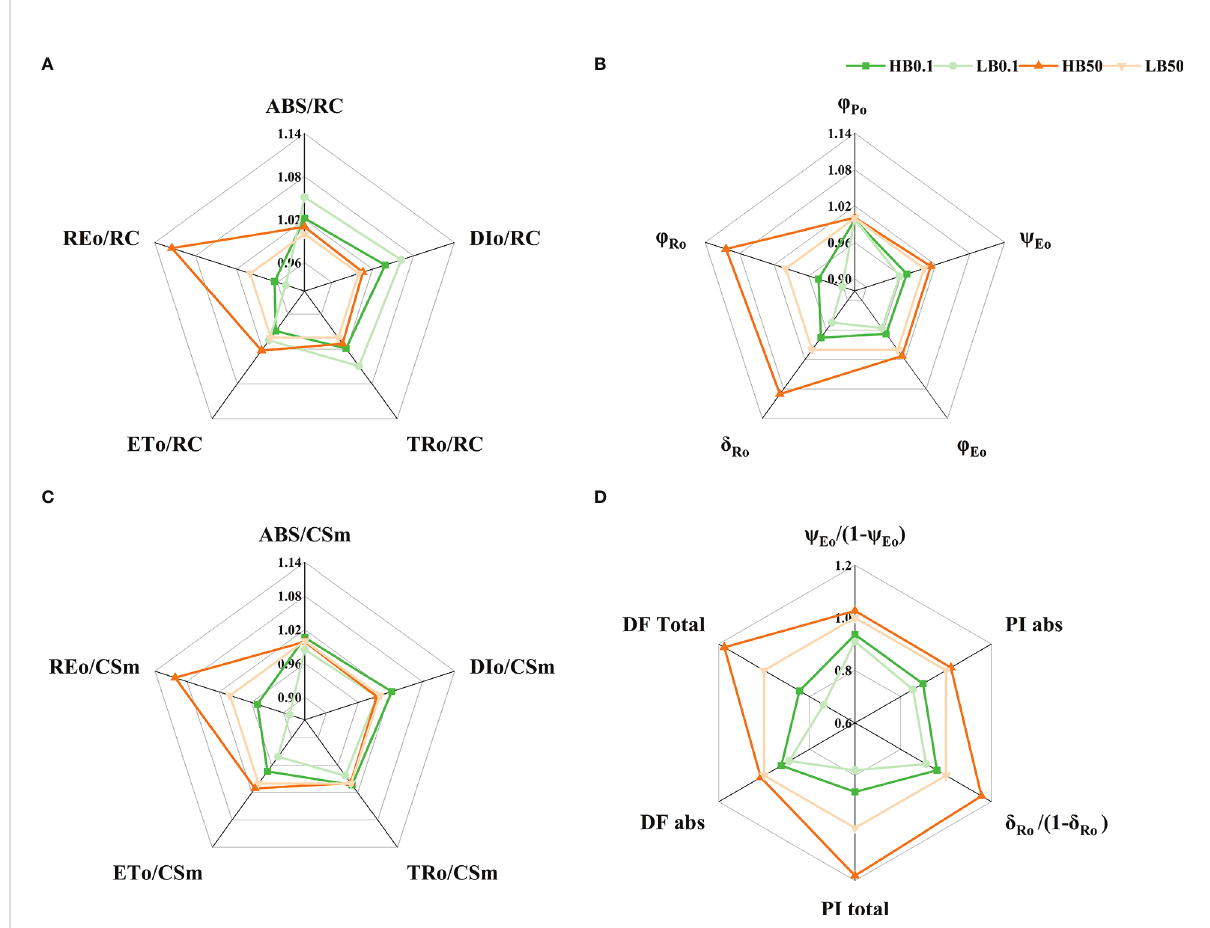
FIGURE 6 Relationships between parameters describing fl uorescence and yield of photosystem II in KW1197(H) and KWS0143(L)cultivars. The seedlings were treated with B de fi cient (0.1 m M H 3 BO 3 , B0.1) and B suf fi cient (50 m M H 3 BO 3 , B50) treatments. The parameters of the energy fl ux of the PSII reaction center of reducible QA (A) , quantum yield and fl ux ratio (B) , phenomenological fl ux per unit leaf section (t= tFM) (C) and performance index (D) . Values are means (n=9) after